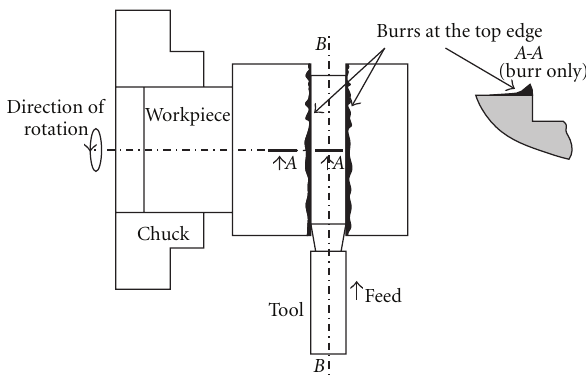
Figure 1: Burrs produced in the rectangular groove cutting